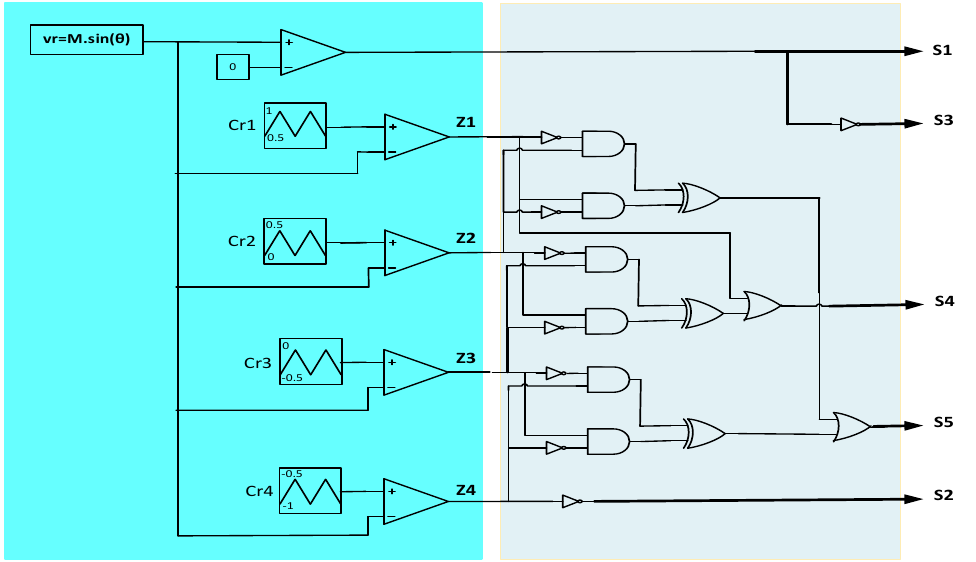
Figure 2. The proposed control technique.